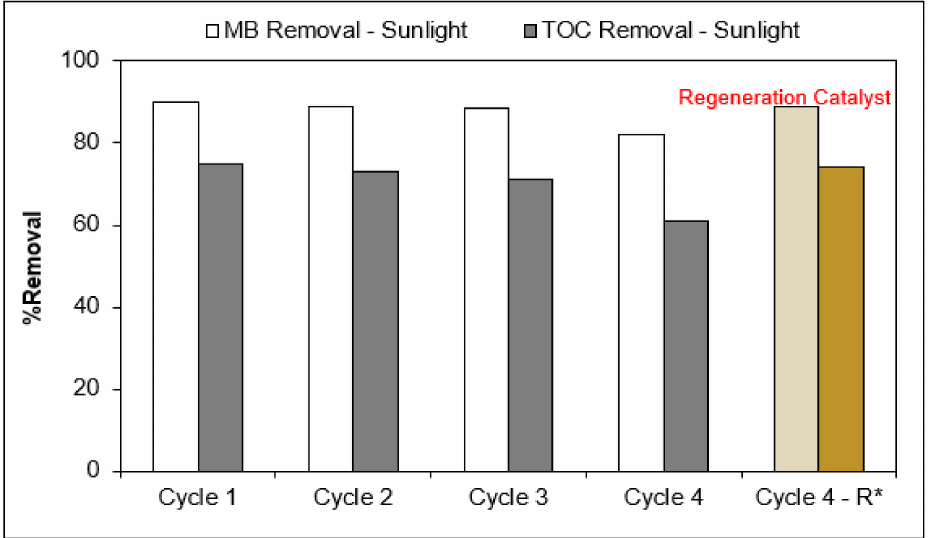
Figure 7. Long-term stability and regeneration performance test of Ag/AgCl-G for MC degradation under the sunlight. * Regeneration